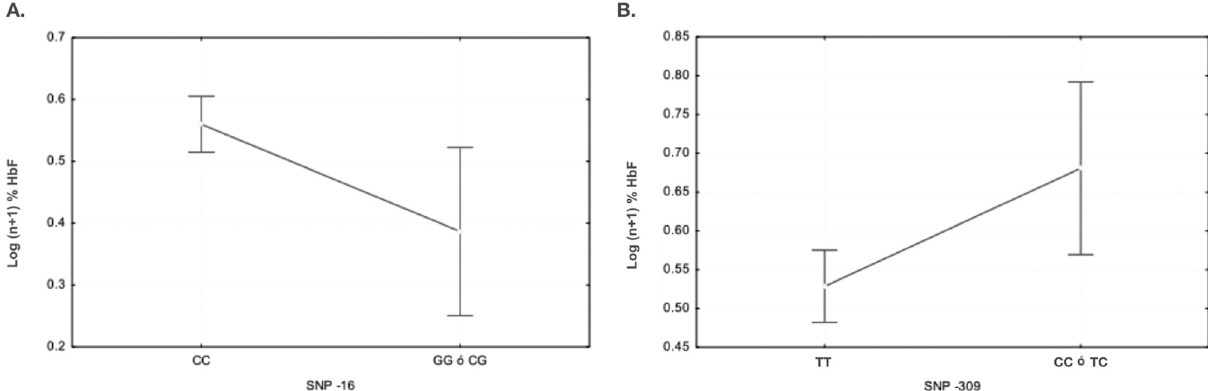
Figure 1 - The effects of -16 and -309 on fetal hemoglobin synthesis. (A) The change from C to G at -16 causes a decrease in the synthesis of fetal hemo- globininindividualswithoutsicklecellanemia.(B)ThechangefromTtoCcausesanincreaseinthesynthesisoffetalhemoglobininindividualswithout the